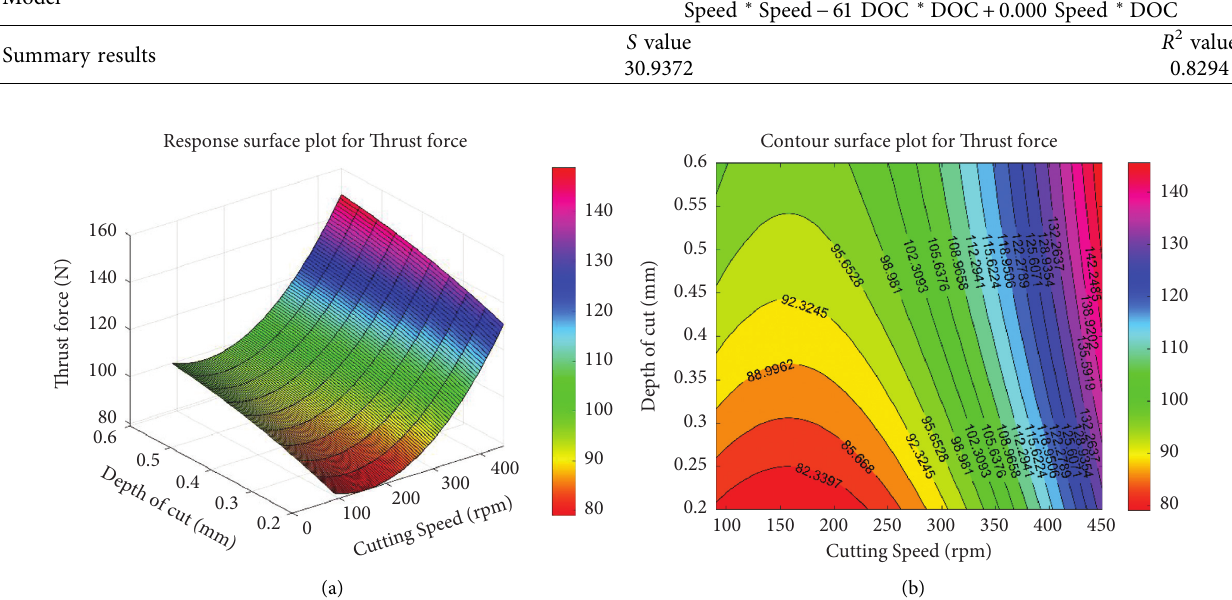
Figure 9: (a) Response surface graph for Torque (type of cutting tool vs. depth of cut). (b)Contour surface plot for Torque (type of cutting tool vs. depth of cut). Table 14: Regression model and summary results for Thrust force. Model